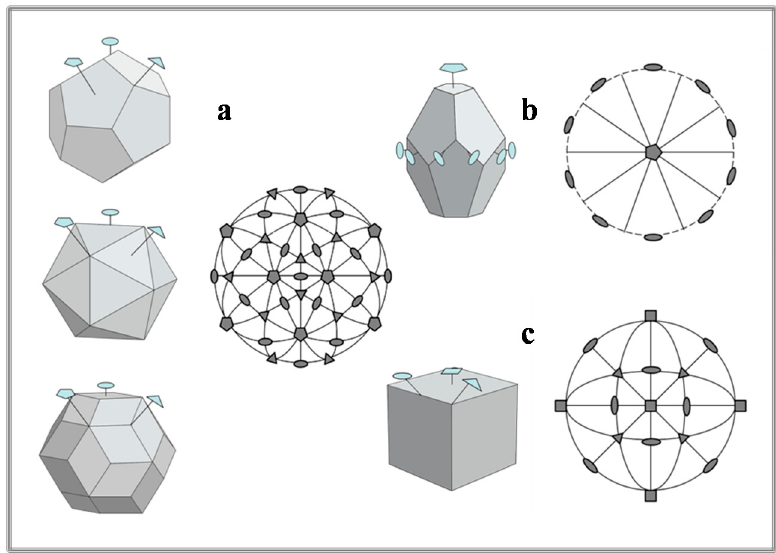
Figure 3. Crystal morphologies reported by Romé de L’Isle [1] and the corresponding stereographic projections of their symmetry elements. ( a ) Forms belonging to the m35 icosahedral quasicrystal class (from top to bottom: dodecahedron, icosahedron, and triacontahedron); ( b ) elongated dodecahedron showing the symmetry of the 5m2 quasicrystal class; and ( c ) cube belonging to m3m crystal class. Symbols: ellipses, triangles, squares, and pentagons indicate the orientations of the twofold, threefold, fourfold, and fivefold axes respectively. The full lines in the stereographic projections represent mirror planes.